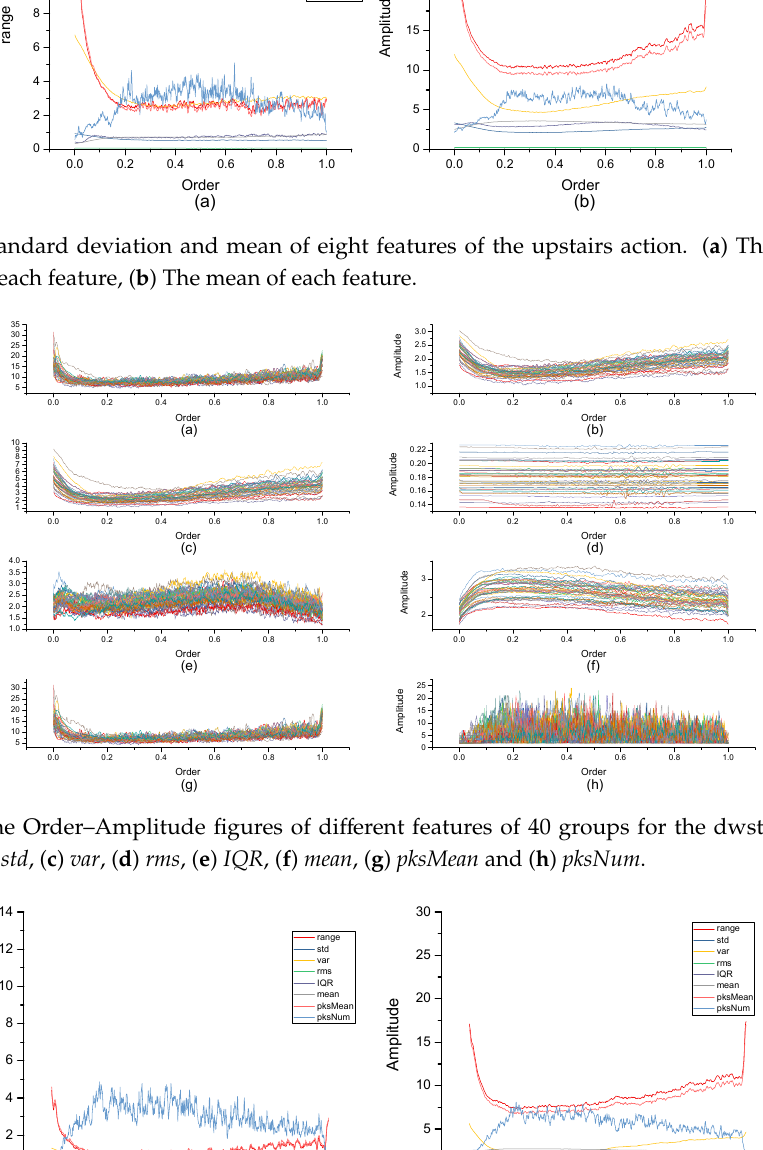
Figure 8. The Order–Amplitude figures of different features of 40 groups for the dwstairs action. ( a )